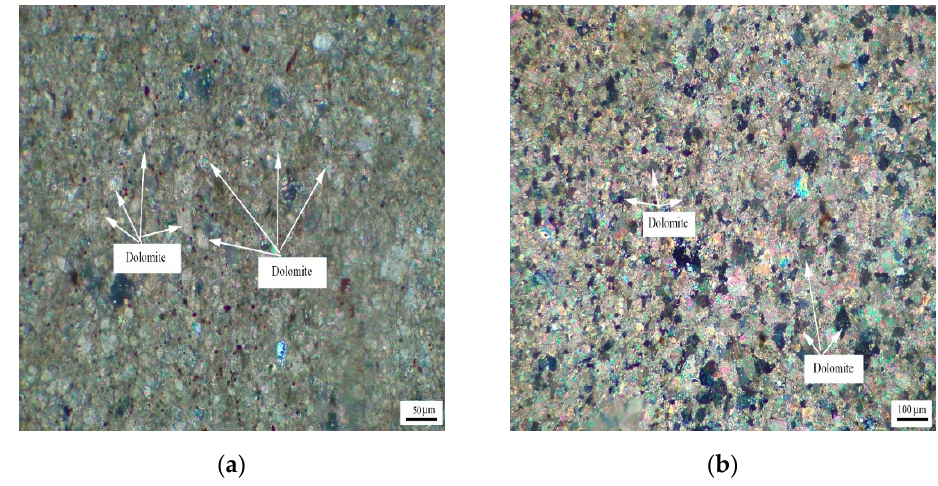
Figure 4. Distribution of dolomites in Cambrian rocks ( a ) BFL-7 and ( b ) BFL-12.